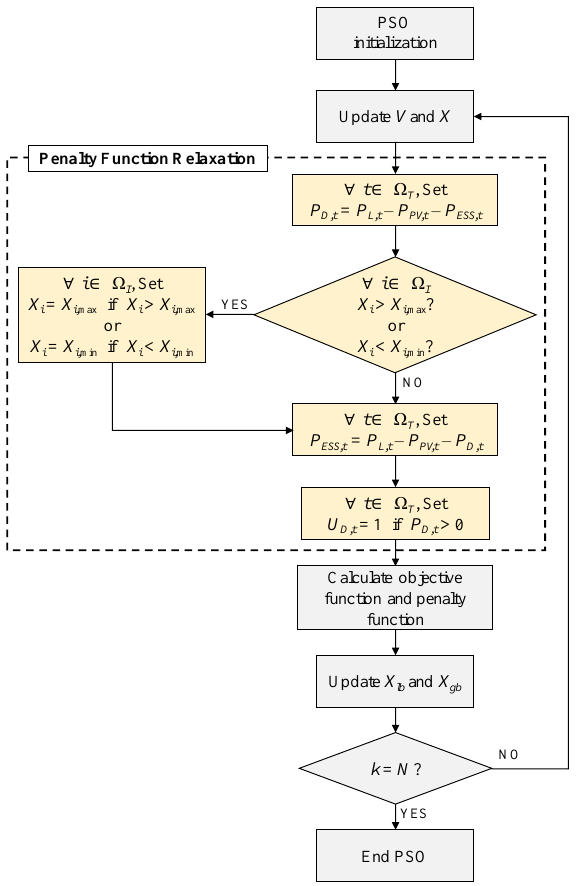
Figure 2. Modified particle swarm optimization (PSO) algorithm flow chart.